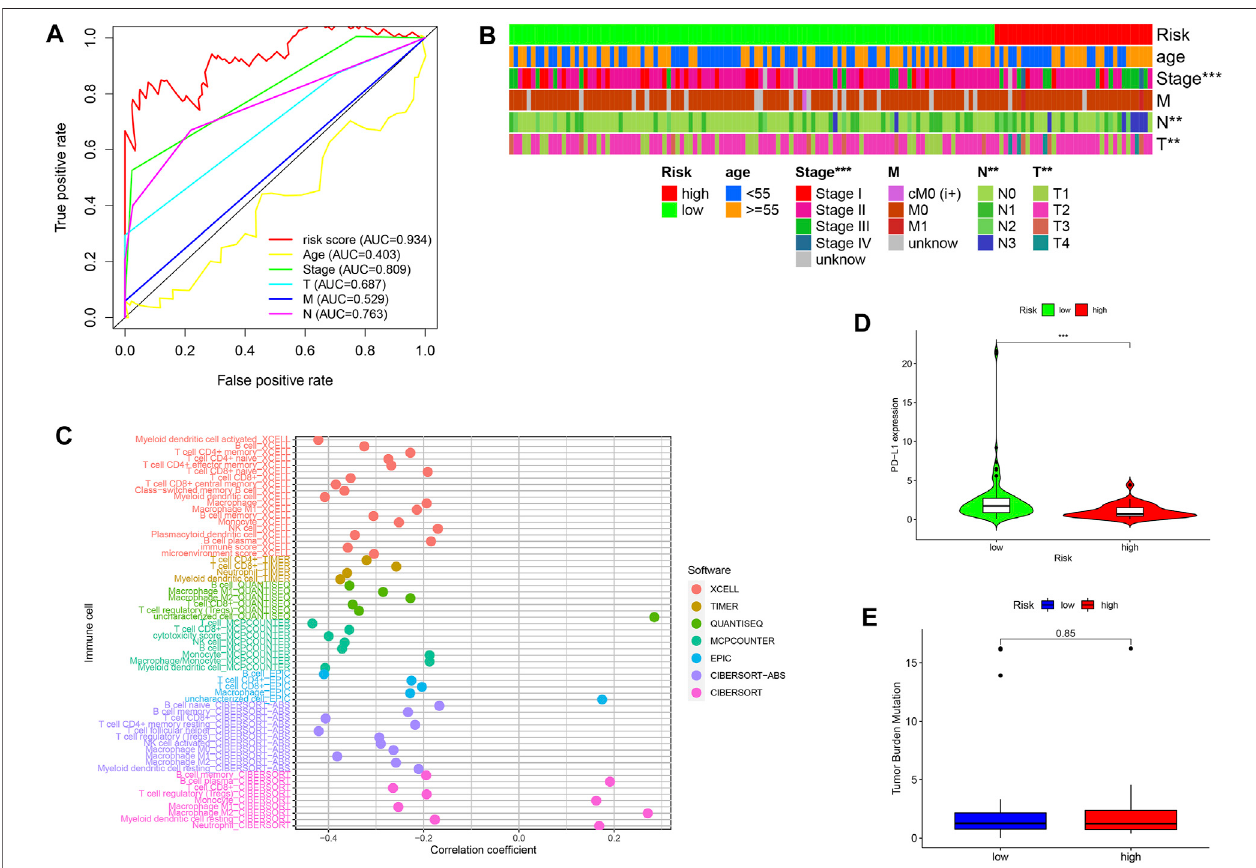
FIGURE 6 | Correlation of the risk score with clinicopathological variables, immune cells, PD-L1 expression, and TMB scores (A,B) A comparison of 5-year ROC curves (A) and correlation analysis (B) between risk scores and traditional clinicopathologic variables. (C) Spearman analysis between risk scores and ICI with seven common methods. (D) Different PD-L1 expression levels in the high-risk and low-risk groups. (E) Compared TMB level in the high-risk and low-risk groups. * p < 0.05; ** p < 0.01; and *** p < 0.001.